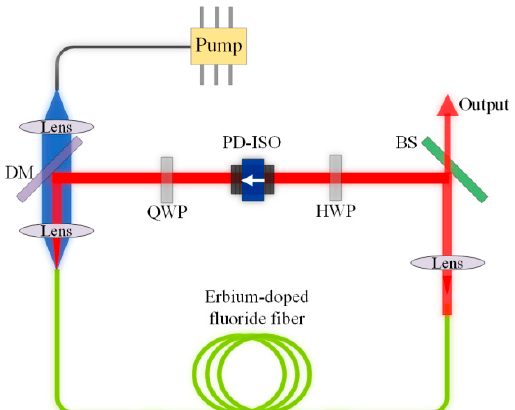
Figure 1. Schematic diagram of the passively mode-locked Er 3+ -doped fluoride fiber laser. PD-ISO, polarization-dependent isolator; QWP, quarter waveplate; HWP, half waveplate; DM, dichroic mirror; BS, beam splitter.